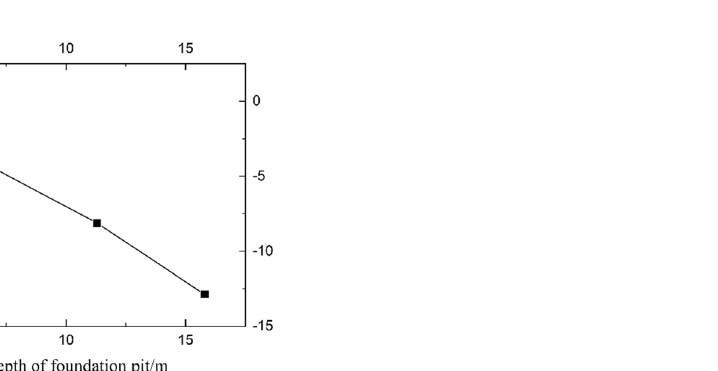
Figure 13. Horizontal displacement curve of shield tunnel under different excavation depths (convex type).